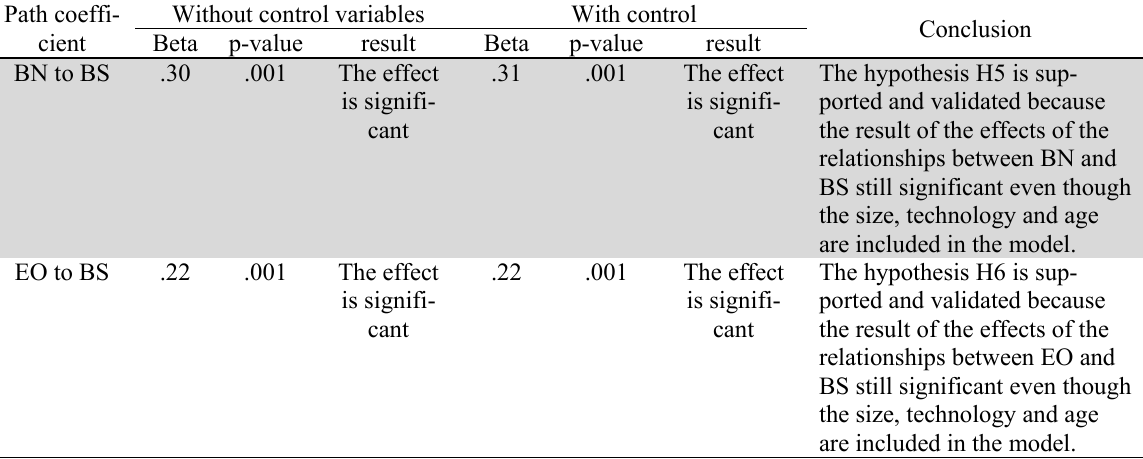
Comparing Beta and p-value for the path coefficient without control variables and with control varia- bles